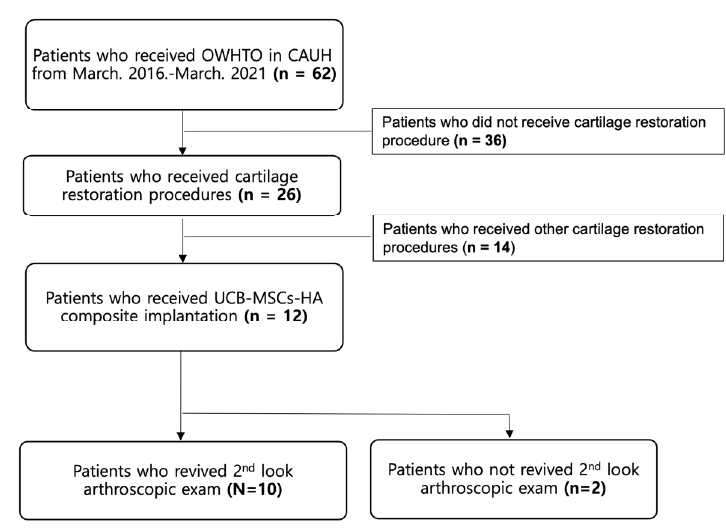
Figure 1. Flow diagram of the included patients.